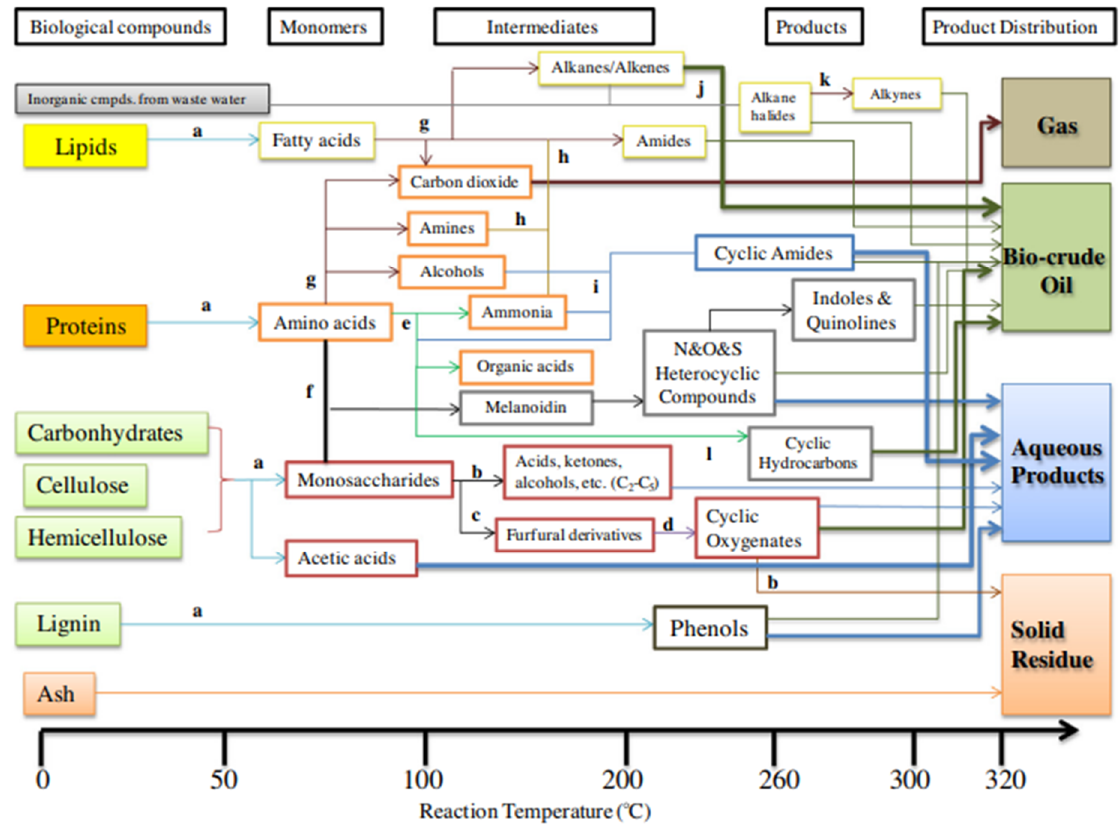
Figure 4. Potential reaction pathways for HTL of AW: (a) hydrolysis; (b) decomposition; (c) dehydration; (d) polymerization; (e) deamination; (f) Maillard reaction; (g) decarboxylation; (h) Aminolysis; (i) cyclization; (j) halogenations; (k) dehydrohalogenation; (l) condensation + pyrolysis. Adopted from [81].